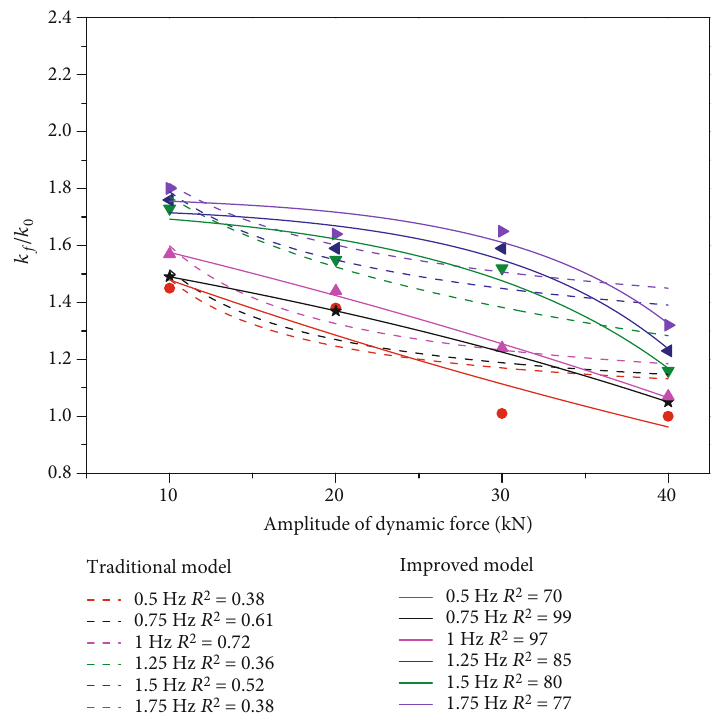
Figure 11: Fitting curves of permeability evolution with amplitude by traditional model Equation (6) and improved model Equation